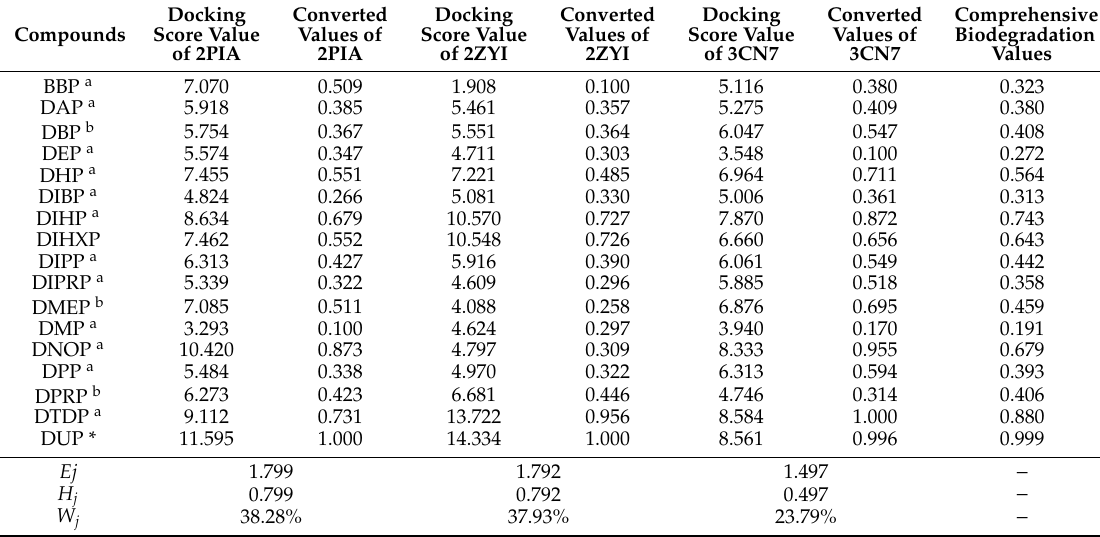
Table 1. Biodegradability score values and comprehensive biodegradability values of the phthalic acid ester (PAE) molecules by three plasticizer-degrading